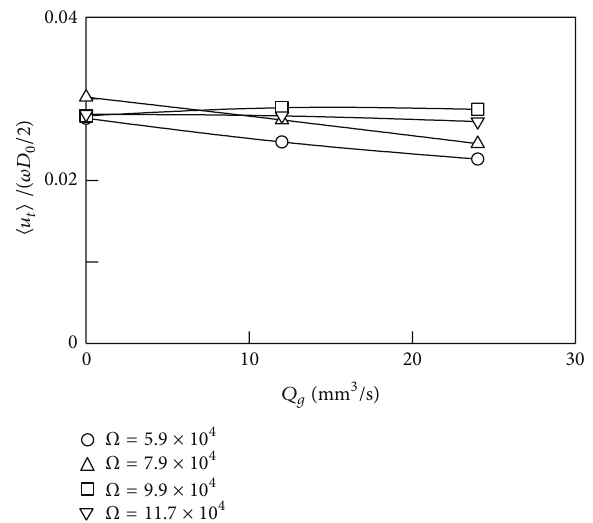
Figure 15: Effect of bubbles on the circumferential velocity of water at 𝑧/𝐷 0 = 4.17